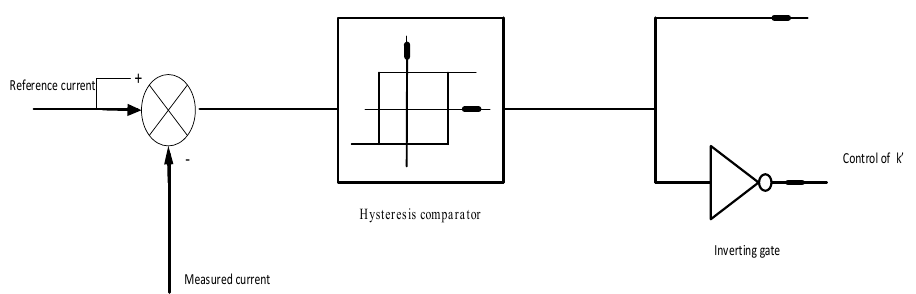
Figure 4. Schematic diagram of the hysteresis pulse-width modulation (PWM) control.